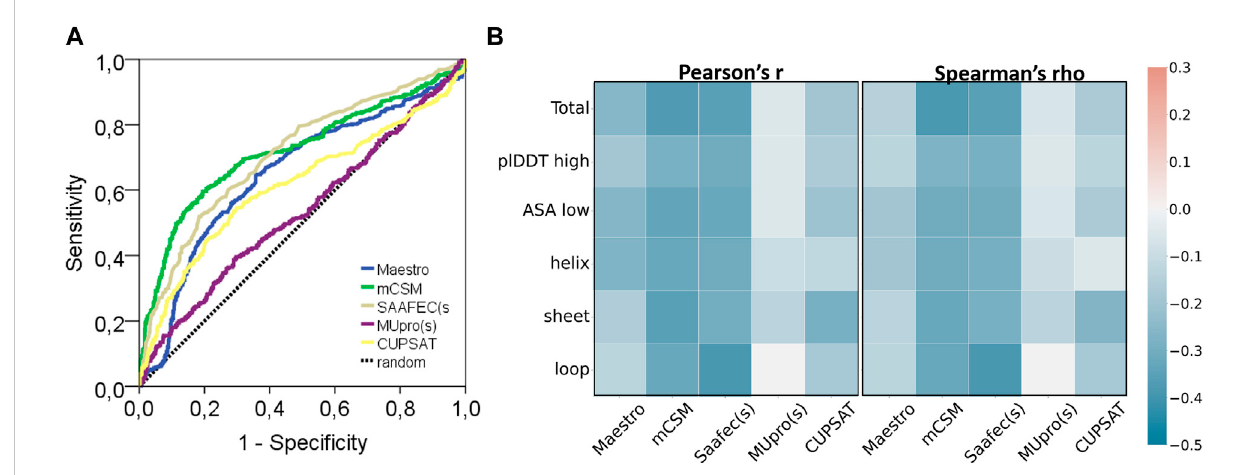
FIGURE 4 Performance of protein stability tools and two characteristics of AF2 structures. (A) ROC curve and (B) correlation analyses of ΔΔ G predictors (pathogenic: 445, benign: 647).